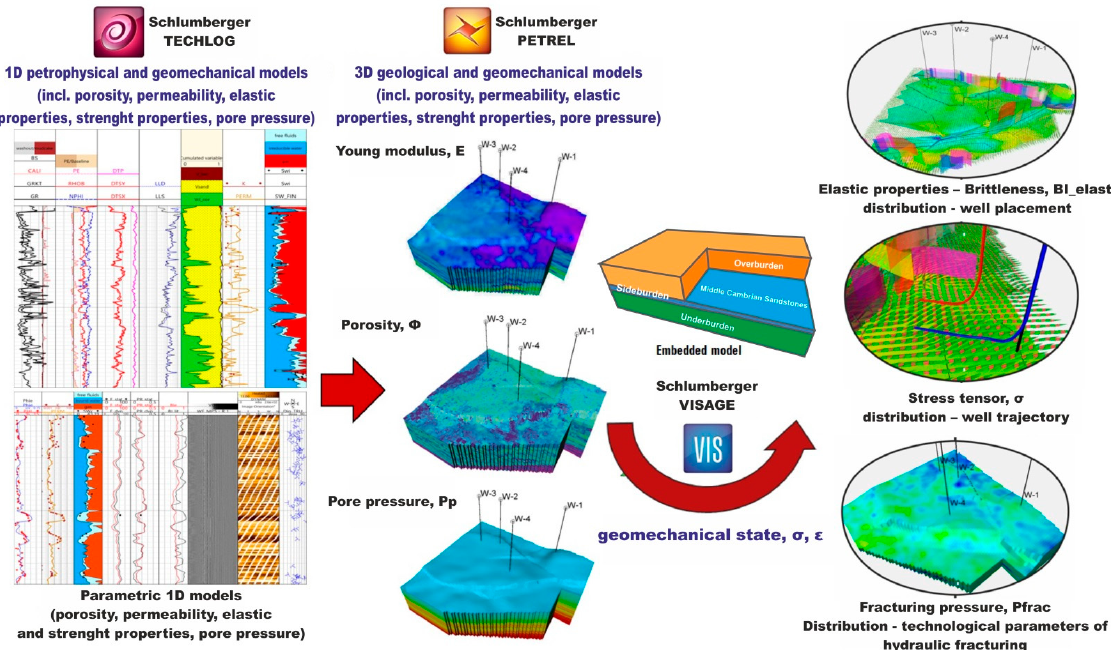
Figure 2. Schematic workflow for characterization of Middle Cambrian tight sandstones.